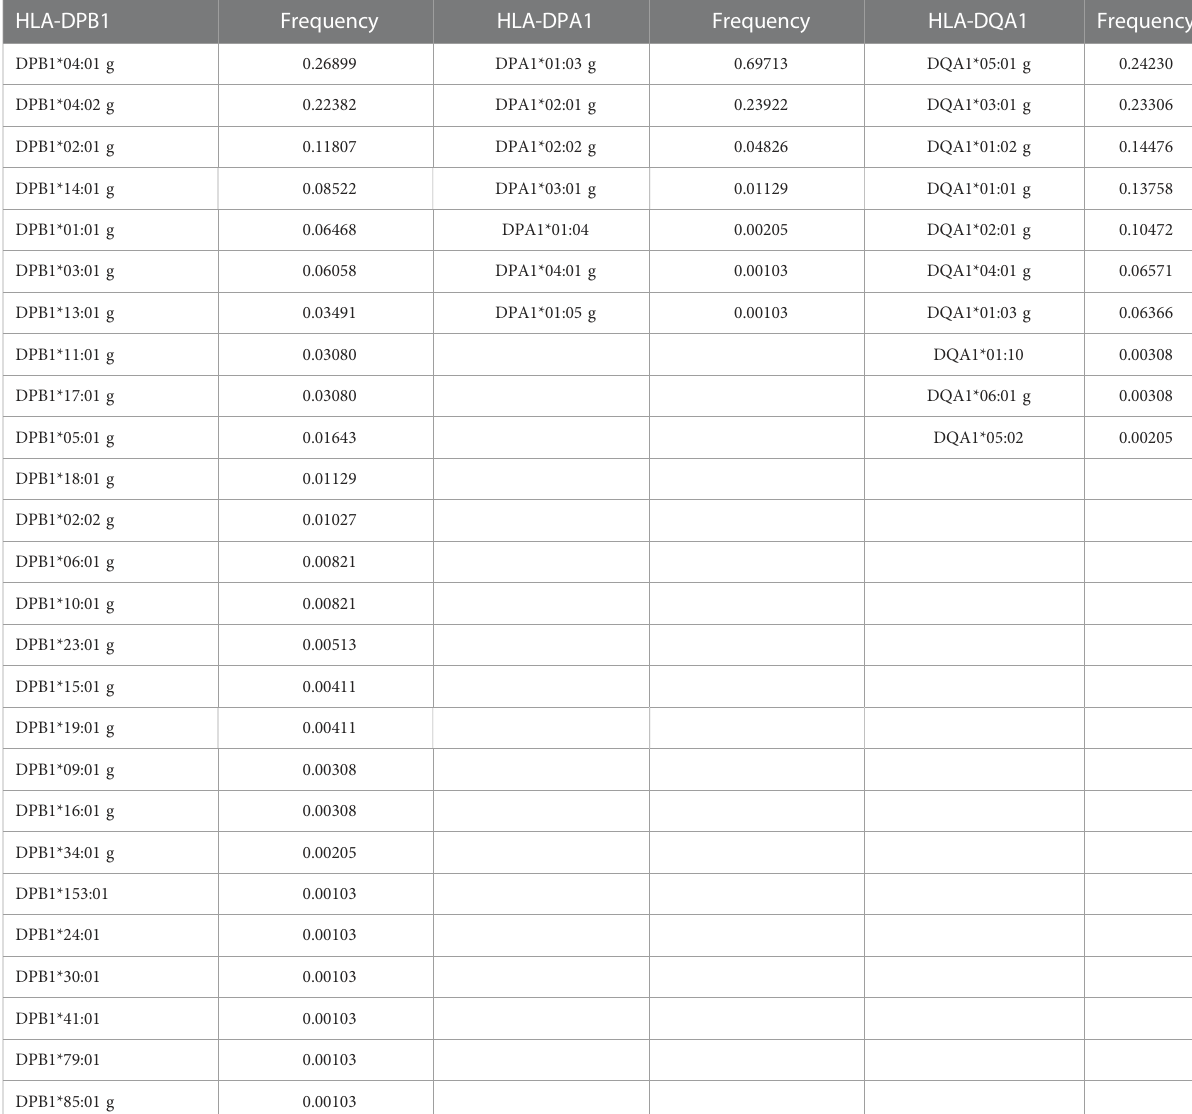
TABLE 6 Allele frequencies for class II, HLA-DPB1, HLA-DPA1, and HLA-DQA1 loci.